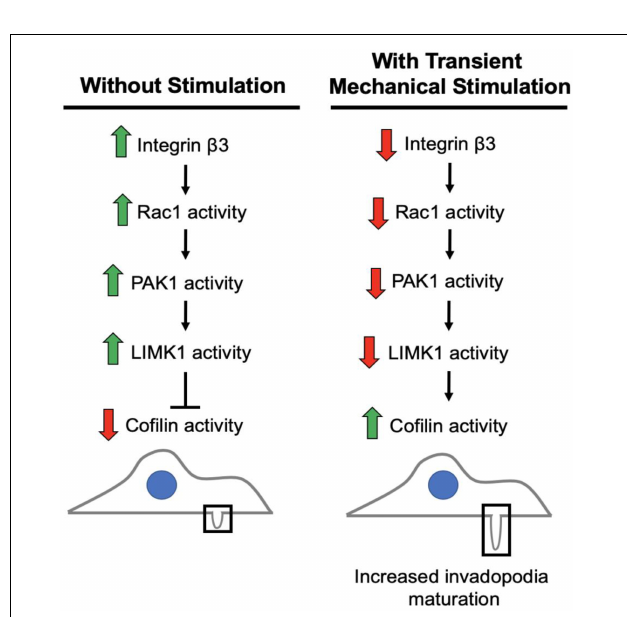
FIGURE 8 | Working model of the pathway to maturation of invadopodia when cancer cells are stimulated by transient tugging forces. The above signaling pathway is proposed to lead to the enhanced invasion observed in fibrosarcoma cells when transient tugging forces are applied through a three-dimensional mechano-invasion assay. Invadopodia elongate and secrete more MMP-2 when the protein expression of integrin beta-3 is downregulated in response to tugging forces. Cofilin is most active when it is not phosphorylated and serves as a kinase substrate of LIMK1, which is activated by PAK1 and subsequently Rac1. Rac1 and LIMK1 have not yet been confirmed to participate in this mechanosensitive